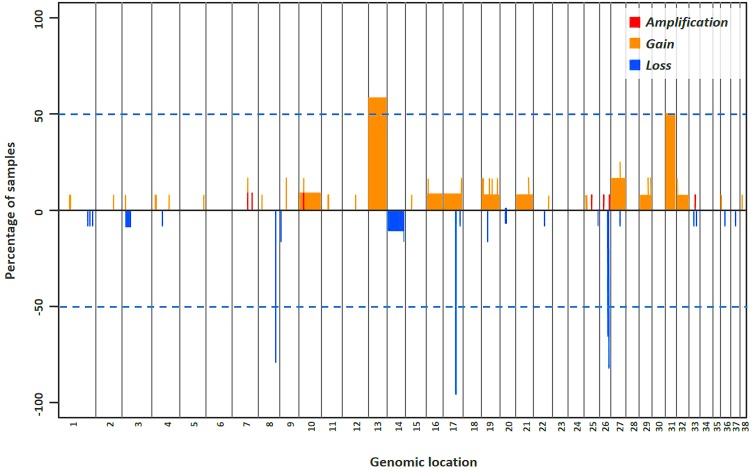
Genomic aberrations in cDLBCL.Frequency plot of CNAs in 12 pre-treatment DLBCLs. Copy number gains/amplifications and losses are indicated as red and blue, respectively. The thresholds of log2 ratio values for single-copy number gains and losses were >0.25 and <−0.25, respectively; the thresholds for high-level gain or amplification were defined as a log 2 ratio >1 and 1.5 respectively.